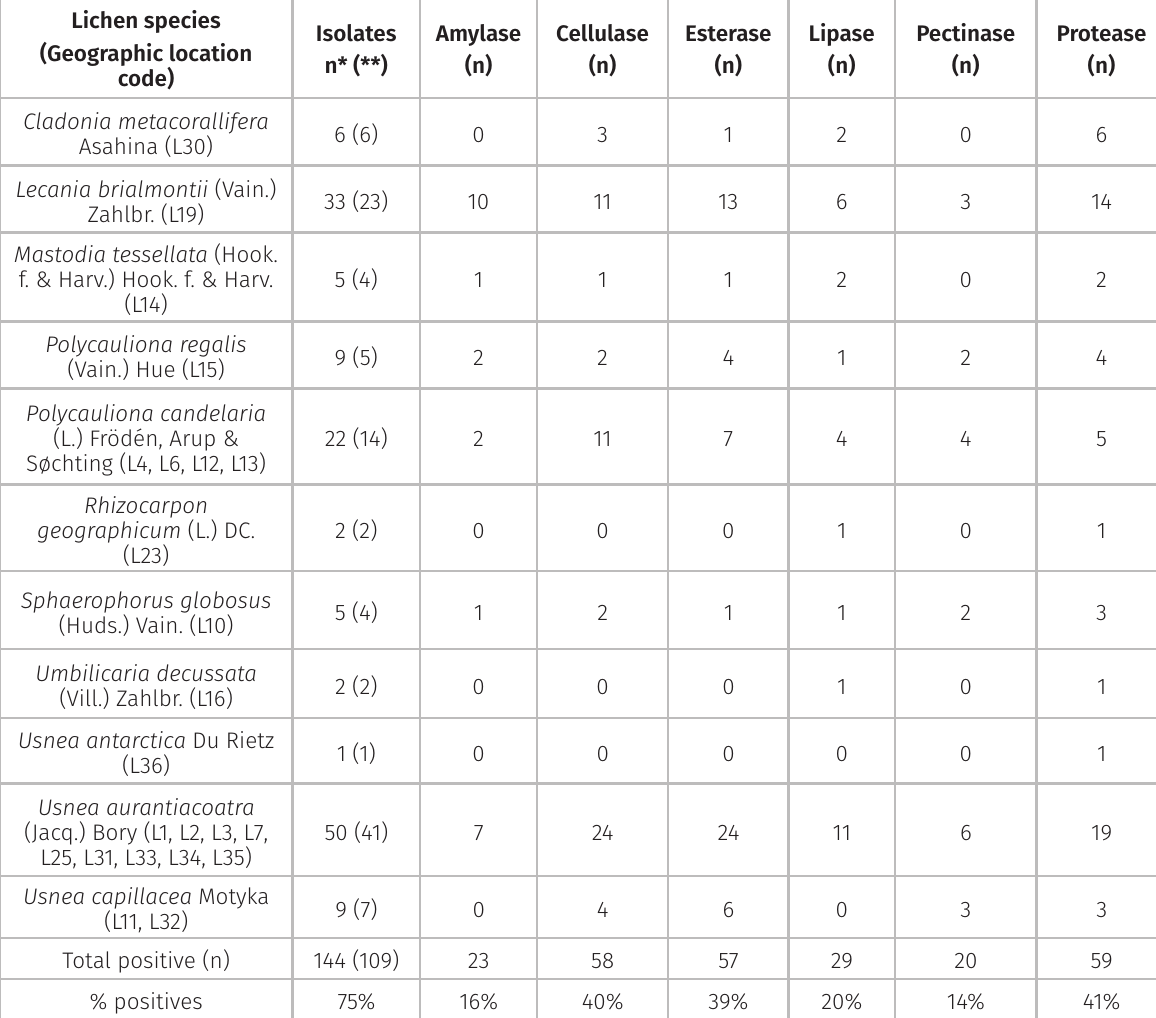
Table I. Number of yeasts isolated from Antarctic lichens with positive enzymatic activity (n). Lichen species (Geographic location code)